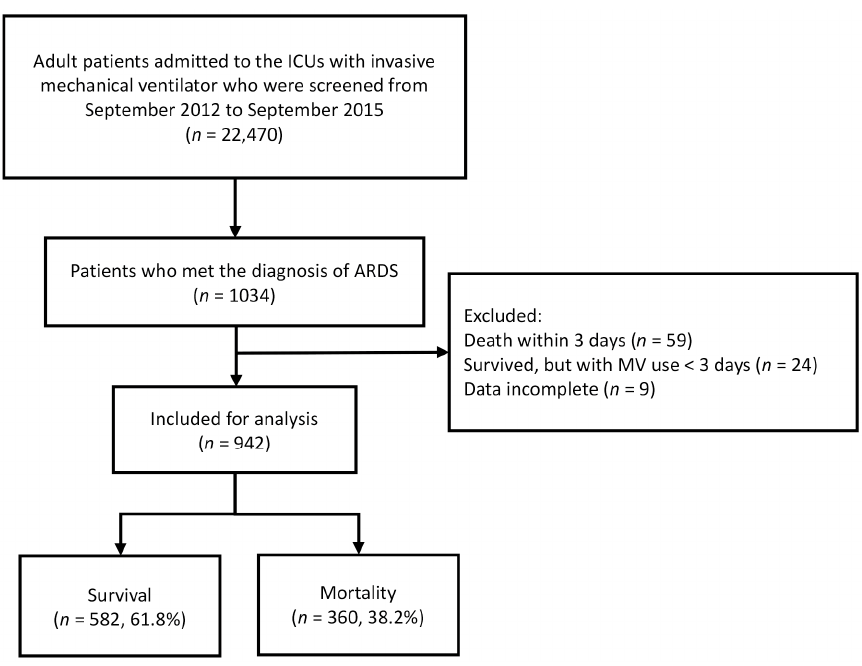
Figure 1. Flow chart of patient selection, enrollment, and exclusion. Abbreviations: ICUs = intensive care units; ARDS = acute respiratory distress syndrome. Compared with the MP and ∆ P upon ARDS diagnosis, the MP and ∆ P significantly decreased after 2 days of ARDS diagnosis in survivors (Figure 2). In non-survivors, MP significantly increased after 2 days of ARDS diagnosis but ∆ P did not. According to the binary logistic regression model, the variables independently associated with 30-day mor- tality included age (odds ratio (OR), 1.012; 95% confidence interval (CI), 1.003–1.022), SOFA score (OR, 1.144; 95% CI, 1.086–1.206), trauma (OR, 0.172; 95% CI, 0.035–0.838), ∆ P (OR, 1.077; 95% CI, 1.044–1.111), change in ∆ P (OR, 1.087; 95% CI, 1.054–1.120), and change in MP (OR, 1.018; 95% CI, 1.006–1.029) (Table 2). Age, SOFA scores, ∆ P, change in ∆ P, and change in MP were positively correlated with 30-day mortality, while trauma was nega- tively correlated with it. The Charison Comorbidity Index and APACHE II score were not associated with 30-day mortality.